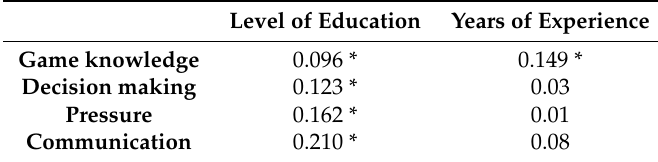
Table 4. Bivariate correlations between REFS subscales, referees’ level of education and